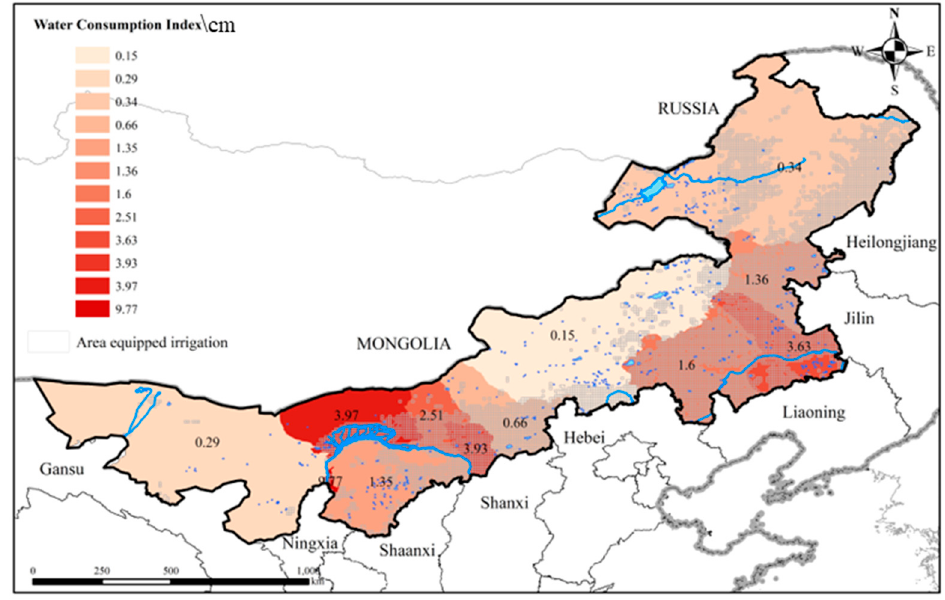
Figure 8. Distribution map of irrigated area and water consumption in Inner Mongolia.